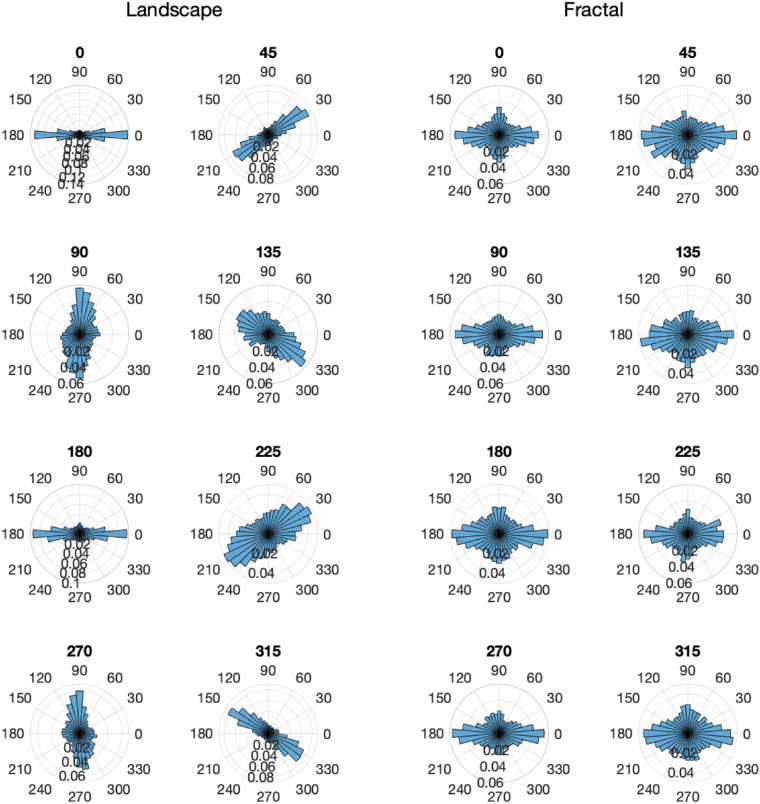
Direction distribution of head shifts in world coordinates, for the landscape scenes (left), and for the fractal scenes (right), for all scene rotations. The histograms indicate relative probabilities and use a bin size of 10°, and the spacing of the inner rings corresponding a probability difference of 0.02.